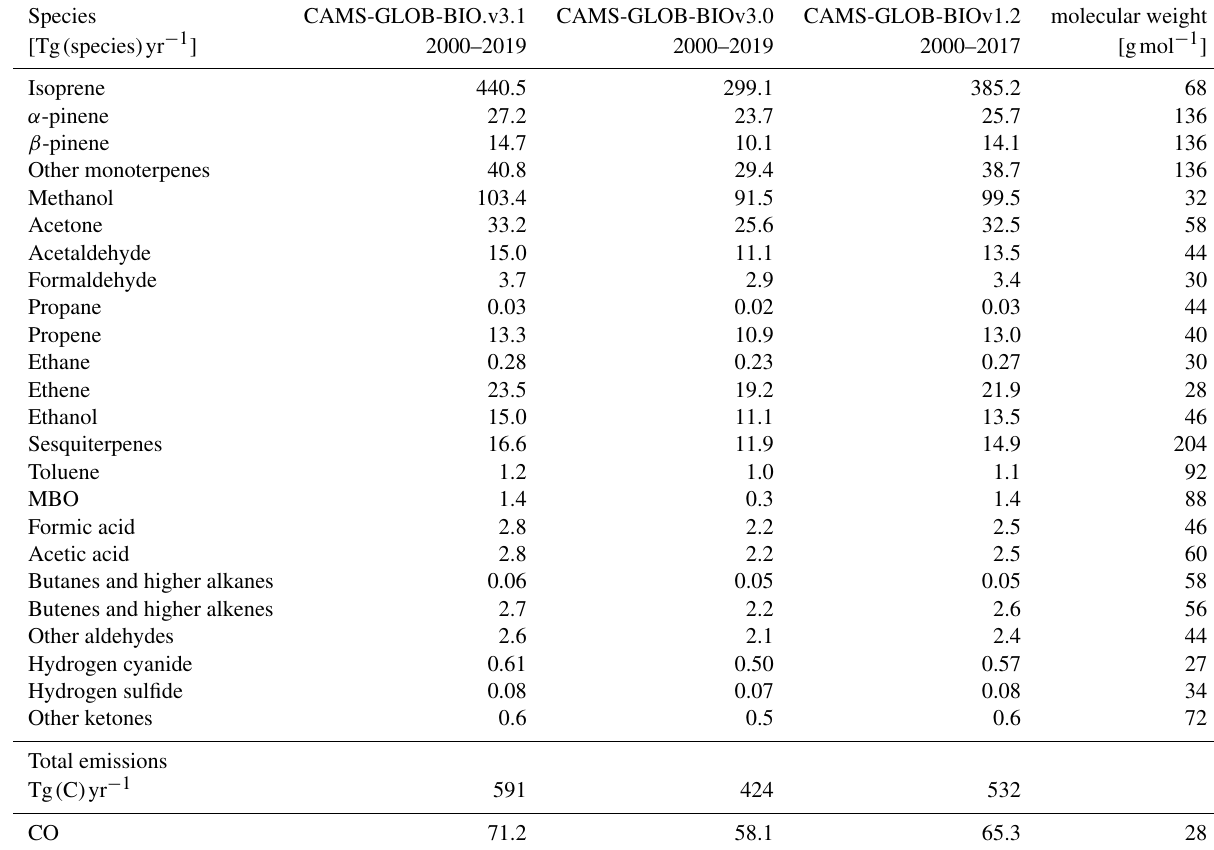
Table 5. List of modelled BVOC species with annual global emission totals (Tg(species)yr − 1 ) in CAMS-GLOB-BIOv3.1, v3.0 and v1.2 inventory averaged over the dataset period. Each species or group is assigned a molecular weight (right column), which was used to calculate total emissions in Tg(C)yr − 1